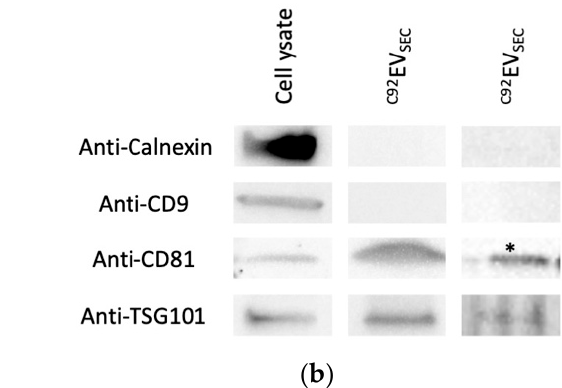
Figure 2. Preliminary characterization of C92 EV SEC . ( a ) Electron microscopy images of C92 EV SEC . Scale bar: 100 nm. ( b ) Enriched proteins in C92 EV SEC identified by Western Blot. * Sample was concentrated before loading on the gel. CD81, TSG101 and CD9 are markers expected to be present or enriched in EVs.